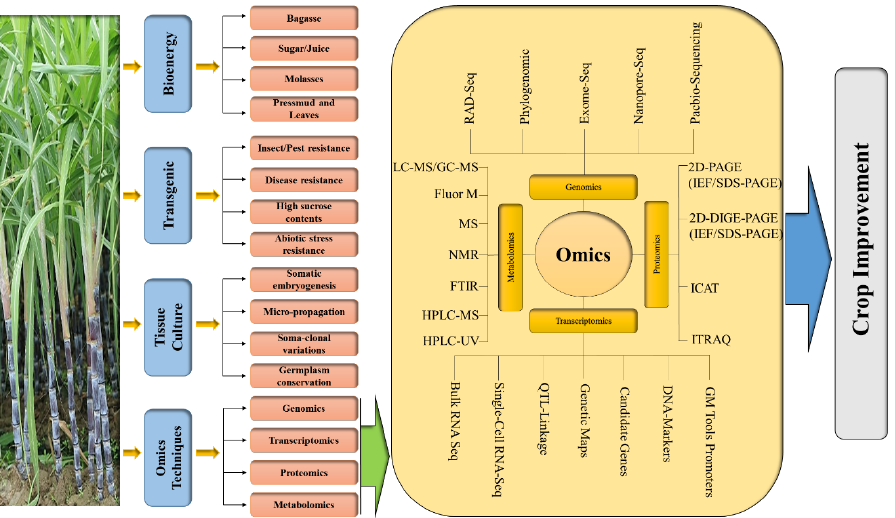
Figure 1. Graphical strategy showing the role of biotechnological interventions for the development of sugarcane crop. Abbreviations: LC, Liquid chromatography; MS, Mass spectrometry; GC, Gas chromatography; Flour-M, Gas chromatography; NMR, Nuclear magnetic resonance; FTIR, Fourier-transform infrared spectroscopy; HPLC, High-performance liquid chromatography; UV, Ultraviolet light; SDS, Sodium dodecyl sulfate; PAGE, polyacrylamide gel; 2D-DIGE, Two-dimensional di ff erence gel electrophoresis; iTRAQ, Isobaric tags for relative and absolute quantitation; QTL, Quantitativetraitloci; GM,Geneticsmodification; ICAT,Isotope-codeda ffi nitytag; RAD-Seq, Restriction site-associated DNA